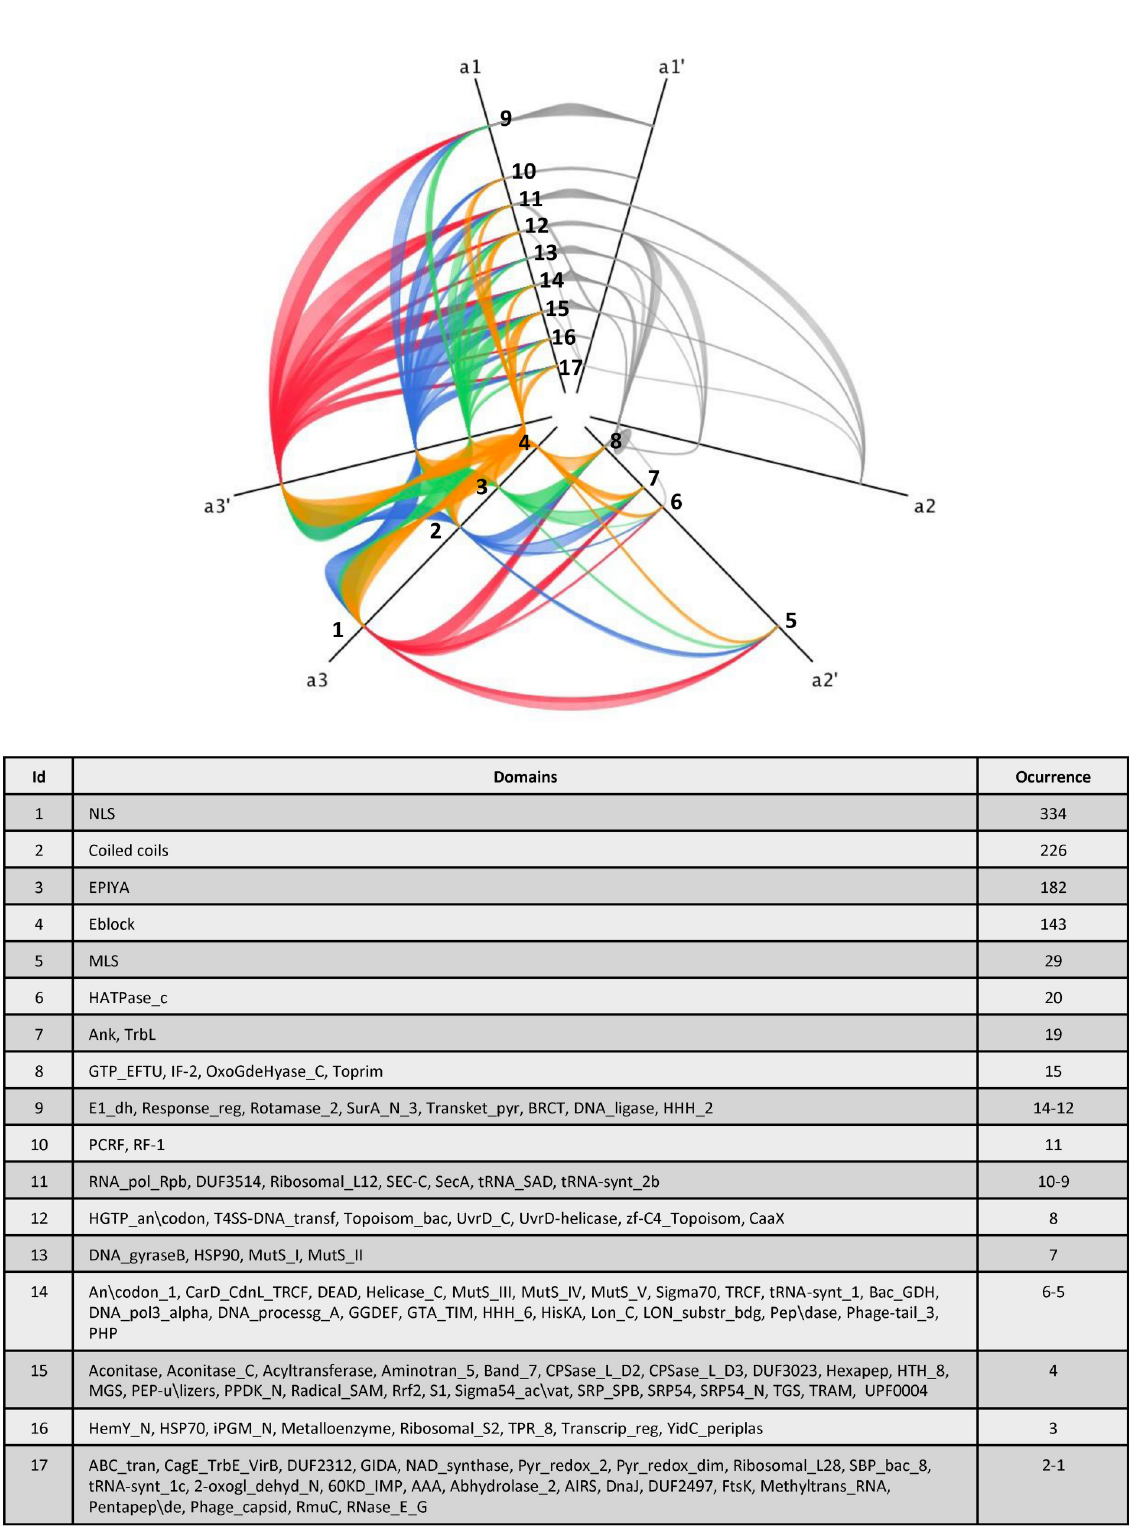
Fig 7. Protein architecture network of Ehrlichia pT4Es shows a large number of interactions between protein domains. This network of protein architecture of pT4Es is drawn using the hive plot algorithm, which is a rational visualization method for drawing networks based on their structural properties. Nodes are mapped to and positioned on radially distributed linear axes, and edges are drawn as curved links. Each node represents a specific domain or a list of specific domains (see table) found in Ehrlichia T4Es predicted by S4TE 2.0. Links